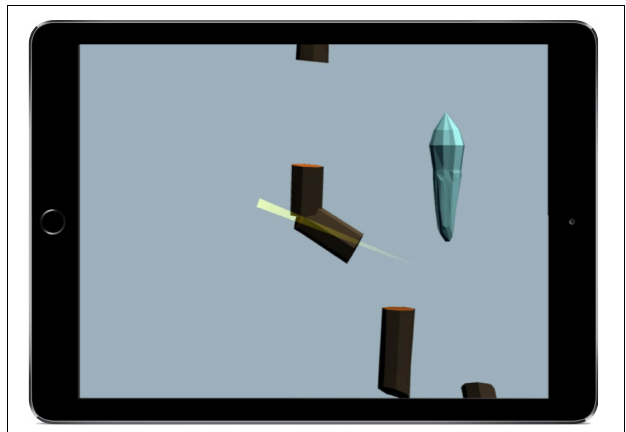
FIGURE 3 | The eFun inhibition game (Log Chop) showing how the logs (go stimuli) get chopped.